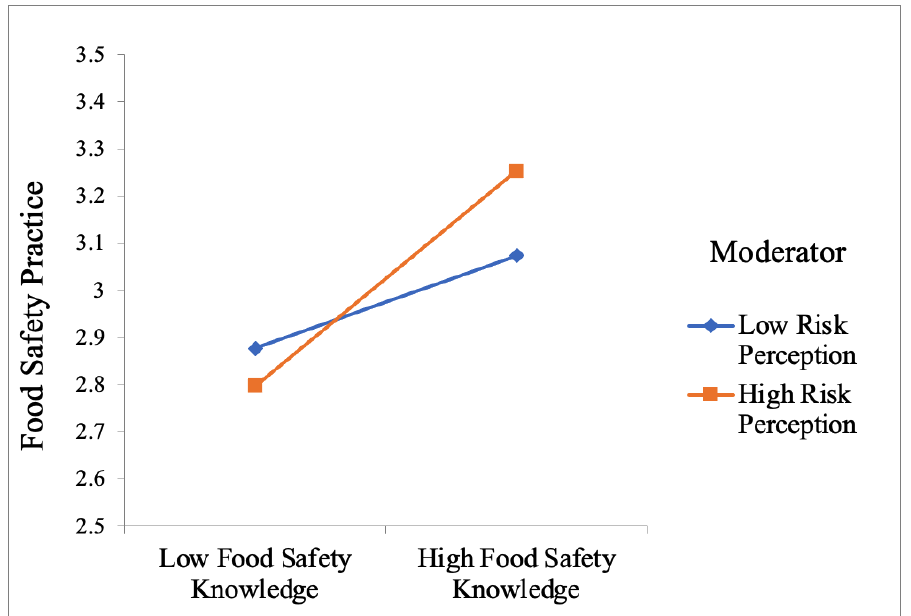
Figure 2. Interaction effect between food safety knowledge and risk perception on consumers’ fresh-cut produce handling practices.